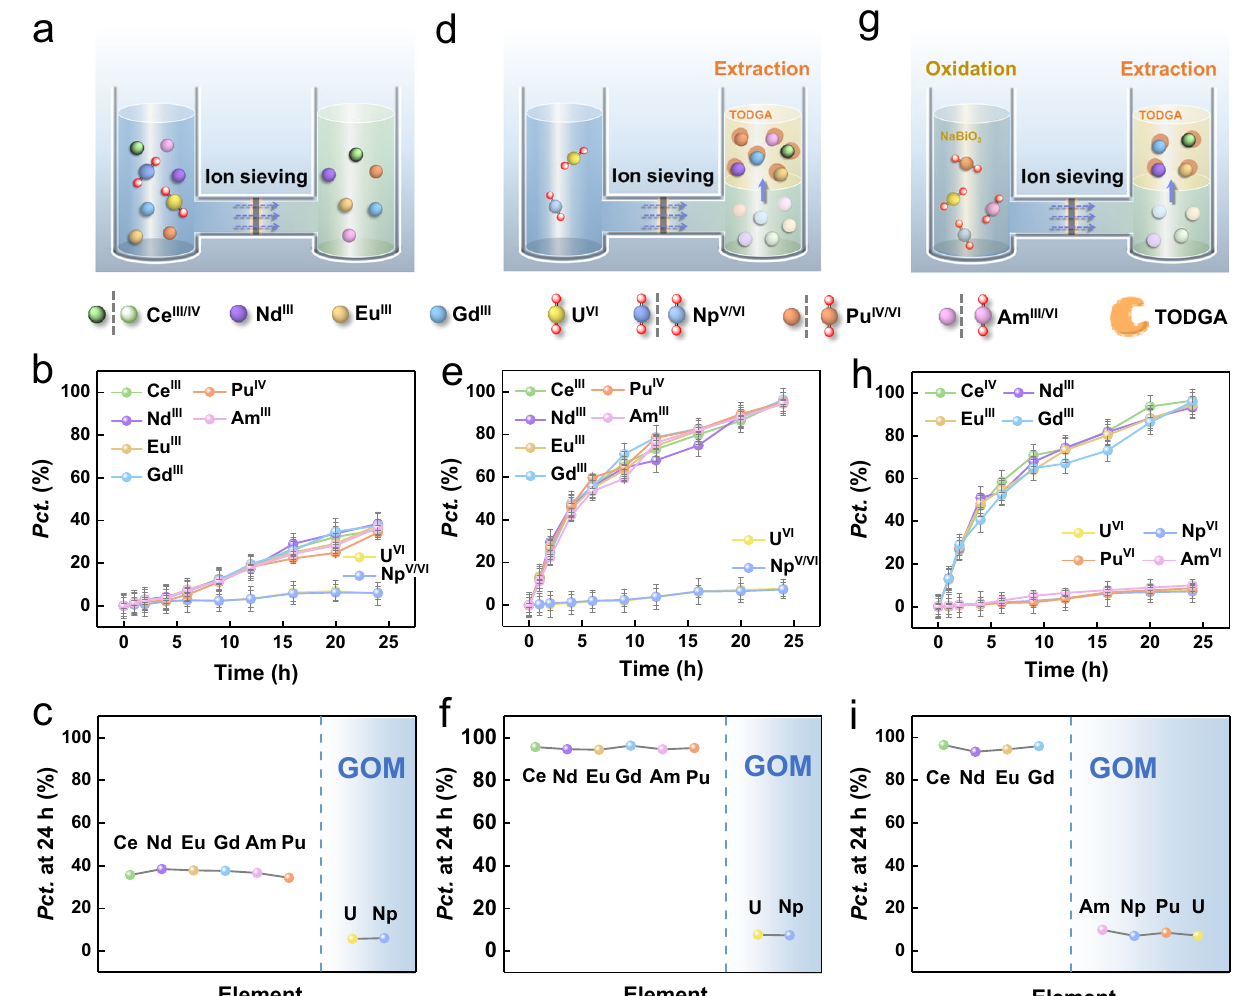
Fig. 3 | Sieving of lanthanide and actinide ions in GOM.a – c Setup for sieving by natural permeation and the permeation percentages ( Pct .) of lanthanides and actinides as a function of time and elements. d – f Setup for sieving through the assistance of extraction and the permeation percentages ( Pct .) of lanthanides and actinides as a function of time and elements. g – i Setup for sieving through the assistance of oxidation/extraction and the permeation percentages ( Pct .) of